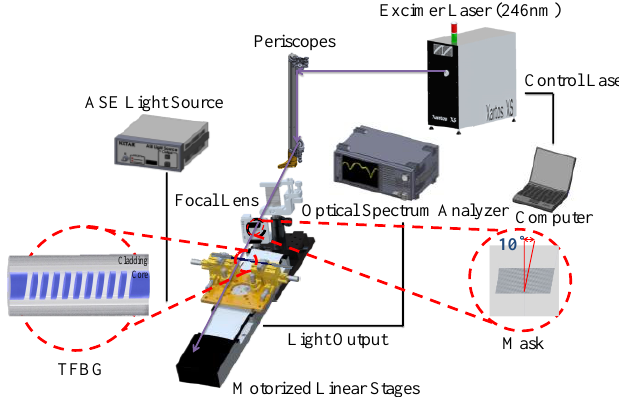
Figure 2. Processing and fabrication of TFBG sensor.